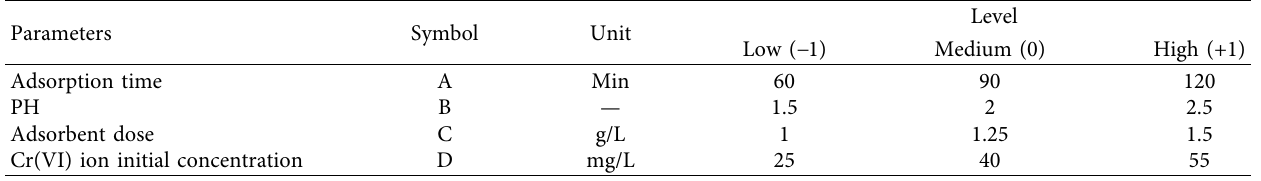
Table 2: Independent parameters and their coded levels for CCD experiments.